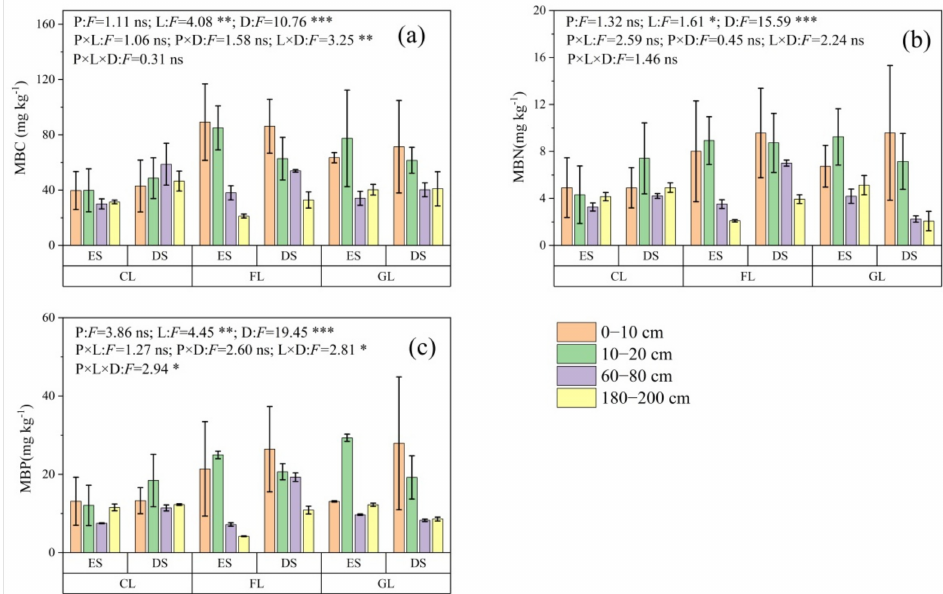
Figure 1. ( a ) Microbial biomass carbon (C), ( b ) nitrogen (N), and ( c ) phosphorous (P) from different soil sites. MBC: microbial biomass carbon; MBN: microbial biomass nitrogen; MBP: microbial biomass phosphorous. CL: cropland; FL: forestland; GL: grassland; ES: eroded site; DS: deposited site.